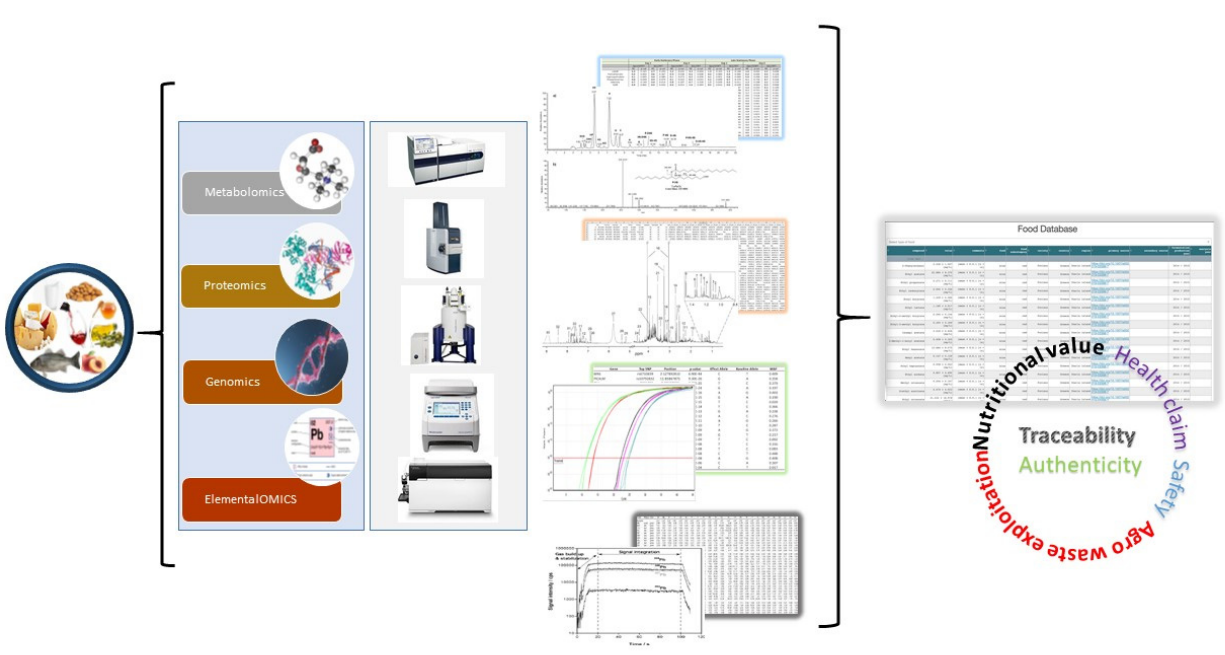
Figure 2. Illustration of the sample path. FoodOmicsGR_RI focuses on the multi-omics analysis of samples by an array of modes in four omics fields (genomics, proteomics, metabolomics and elemental metabolomics) and the fusion and combination of the data to create a comprehensive atlas of the food content for selected Greek foods.